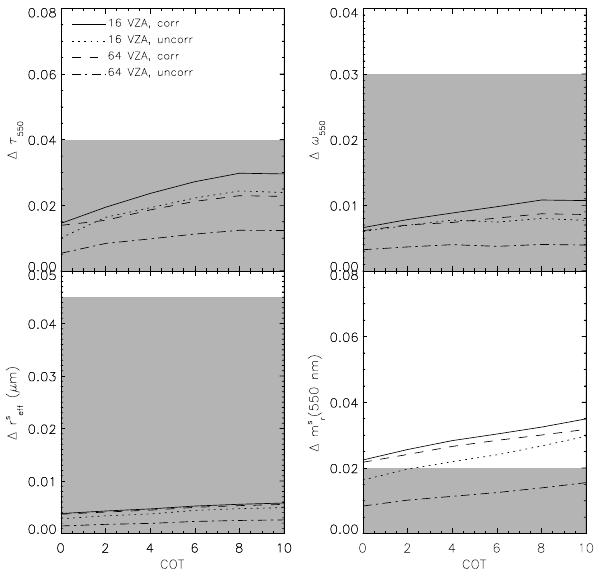
Fig. 7. Retrieval error on the aerosol optical thickness (upper left panel), single scattering albedo (upper right panel), fine mode effec- tive radius (middle left panel), coarse mode effective radius (middle right panel), fine mode real refractive index (lower left panel), and coarse mode effective radius (lower right panel), as a function of cloud optical thickness (COT) for a situation with a biomass burn- ing aerosol layer with AOT=0.5 situated between 4–6km over a fully cloudy scene with a cloud layer between 2–3km. Simulations have been performed for multi-angle photo-polarimetric measure- menst with respectively 16 and 160 viewing angles. Polarimetric accuracies of 0.002 and 0.005 have been considered and a radio- metric accuracy of